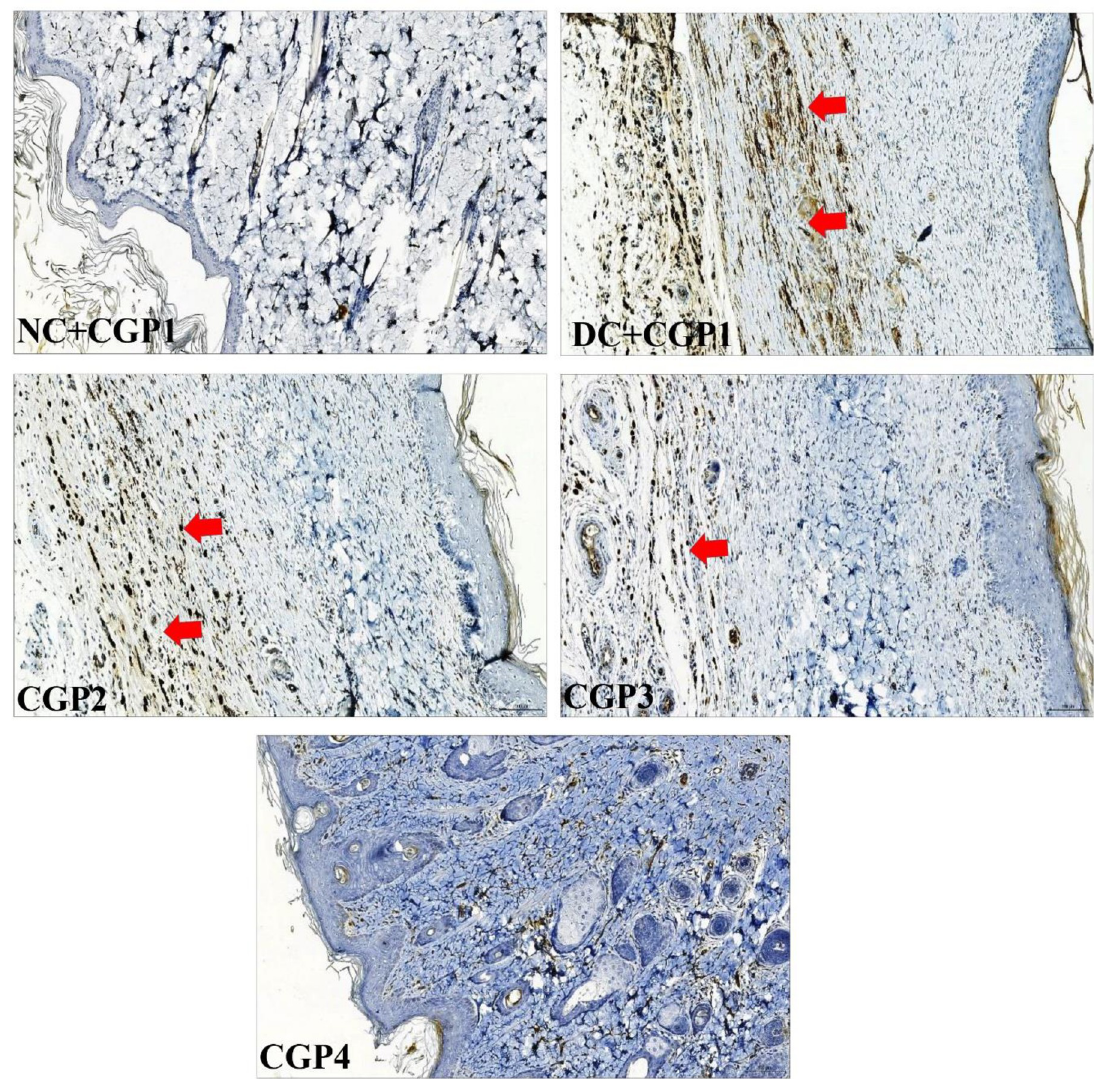
Fig 6. Effect of GC-AgNP CGPs dressing on c-fos in diabetic rats. Immunohistochemistry staining of c-fos (brown color). Red arrows point towards the distribution of c-fos protein in brown color. NC+CGP1: Normal control dressed with blank cotton gauze; DC +CGP1: Diabetic control rats dressed with blank cotton gauze; CGP2: Diabetic rats dressed with 13.06 μ M gallocatechin and silver nanoparticle (GC-AgNP) impregnated cotton gauze patches (DC+ 13.06 μ M CGP2); CGP3: Diabetic rats dressed with 26.12 μ M gallocatechin and silver nanoparticle (GC-AgNP) impregnated cotton gauze patches (DC+ 26.12 μ M CGP3). CGP4: Diabetic rats dressed with silver sulfadiazine (DC+AgS) impregnated cotton gauze patches. Data were expressed as mean ± S.E.M (n = 6). � p < 0.05 compared to control, # p < 0.05 compared to DC. Scale bar = 100 μ